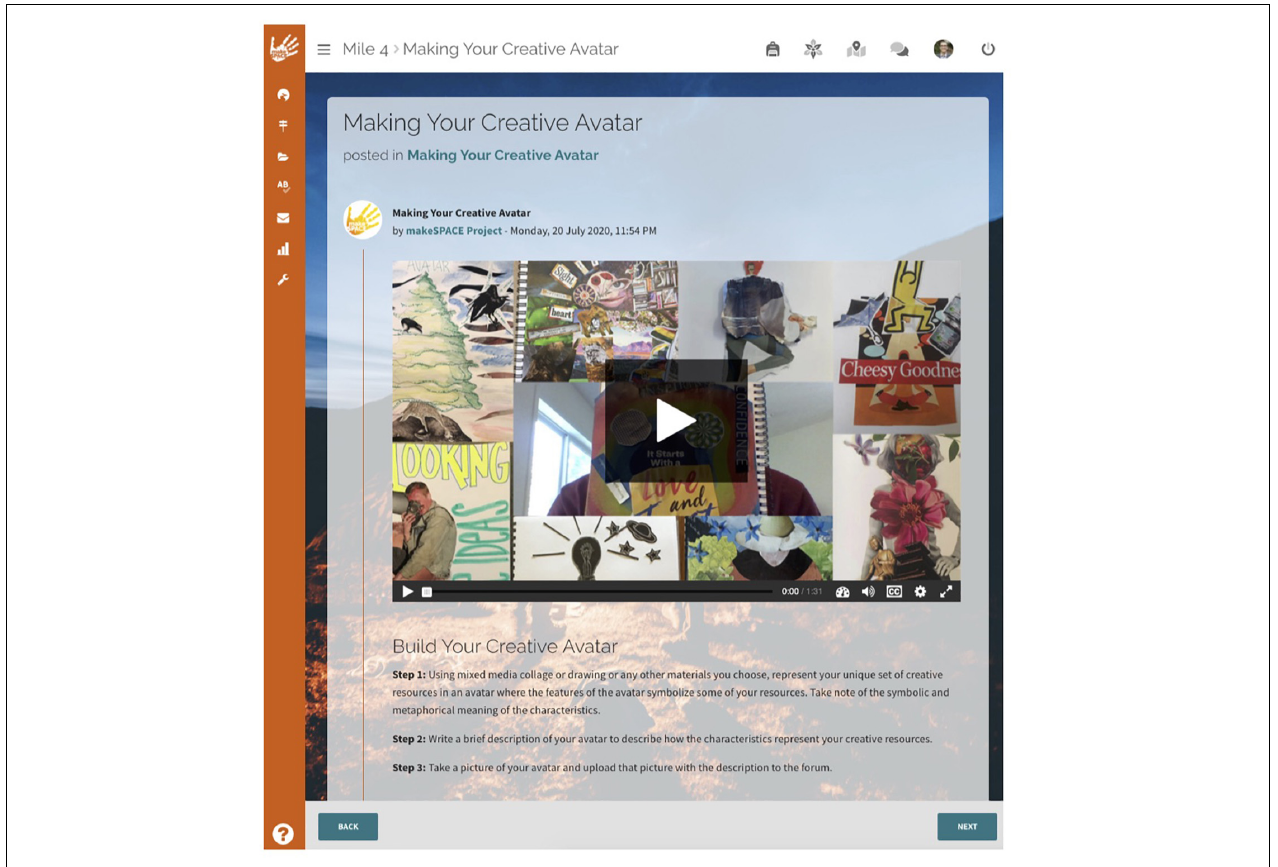
FIGURE 2 | Sample creative and artistic exercise in the online professional development course in creativity and arts integration showing the activity prompt and sharing